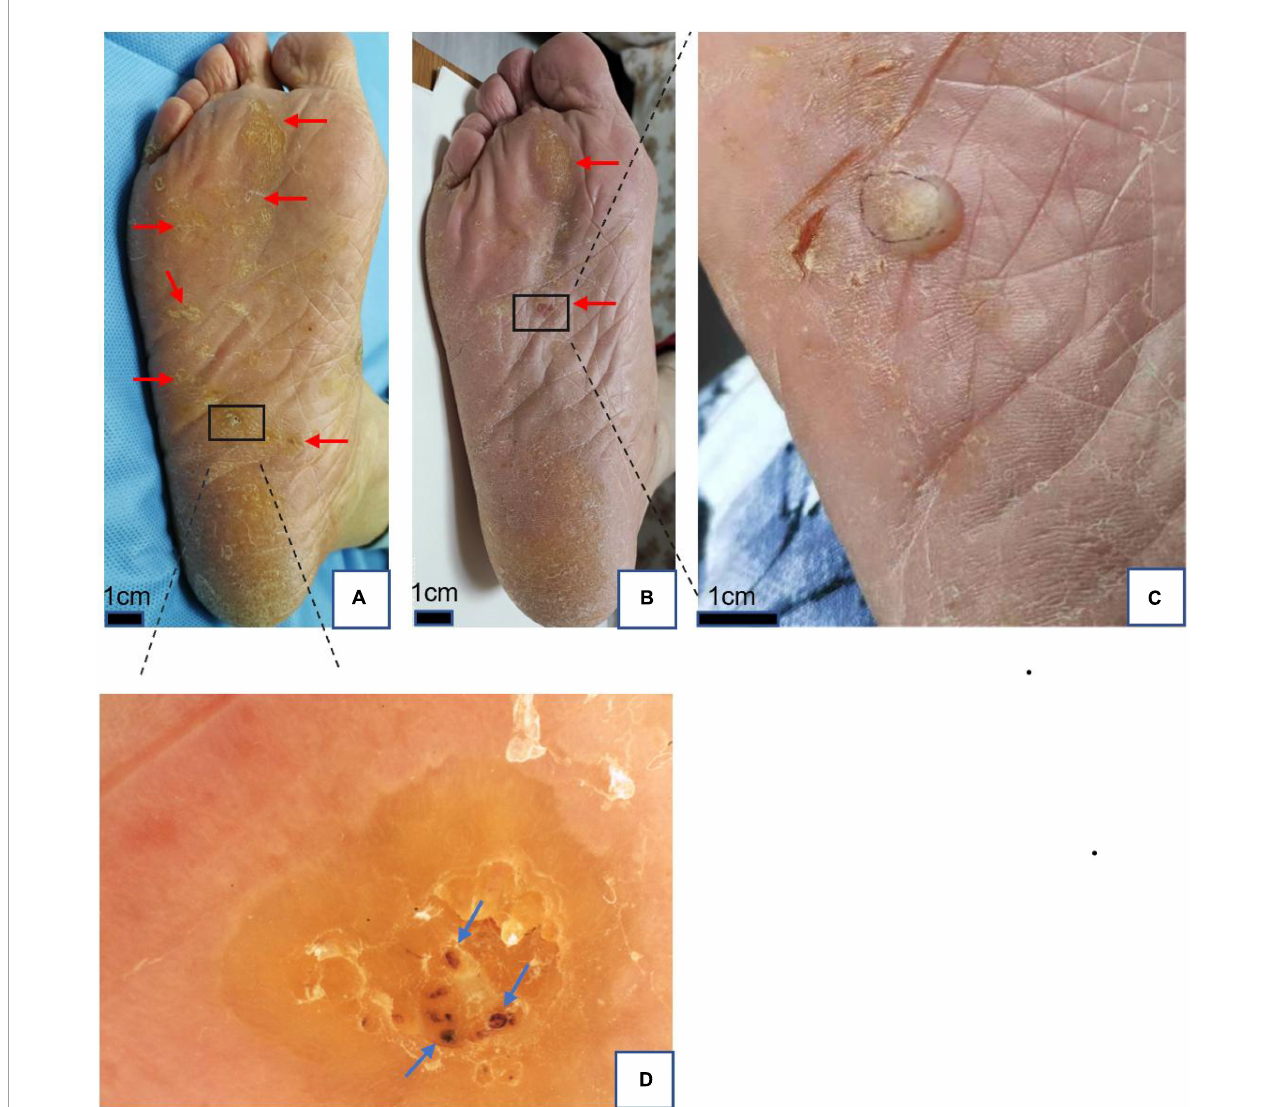
FIGURE3 (A) Plantar warts (red arrows) before treatment. (B) Two months after treatment with local hyperthermia (partial remission). (C) Bullae at targeted warts after treatment. (D) Dermoscopic findings in warts; yellowish structureless with bleeding streaks and spots (blue arrows) appearance on the papilliform surface. Dermoscope 50 × magnification.